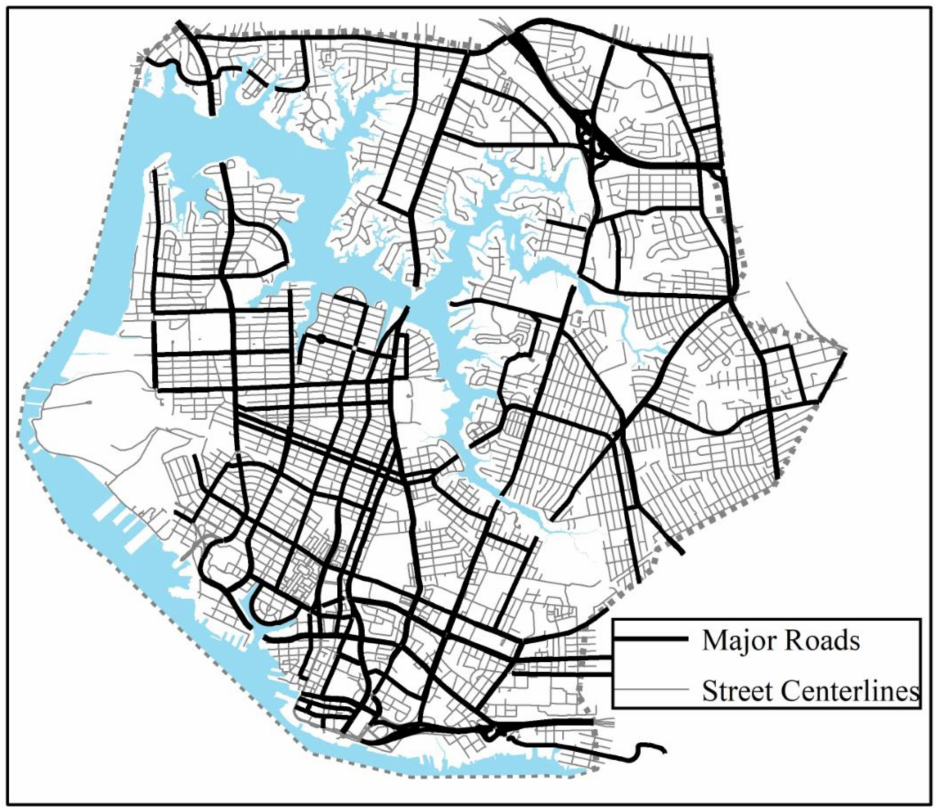
Figure 6. Transportation network inside the study